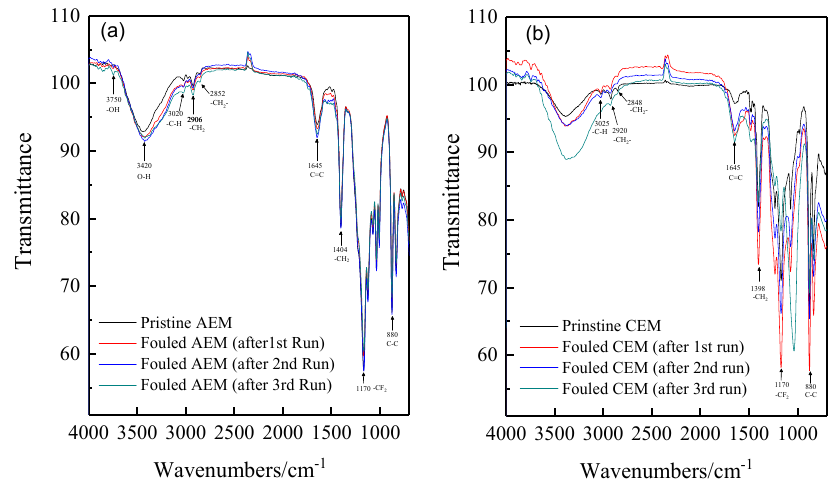
Figure 4. The FT-IR (ATR) spectra of the pristine and fouled anion and cation exchange membranes. ( a ) anion exchange membrane; ( b ) cation exchange membrane.